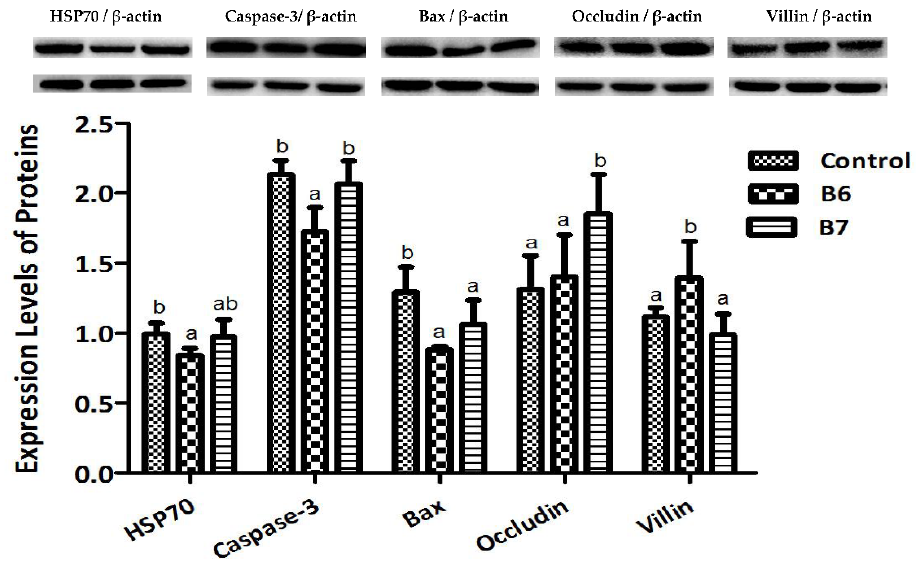
Figure 2. Effects of B. coagulans on the expression levels of proteins in the jejunum. a,b Values within a row with different letters differ ( p < 0.05).